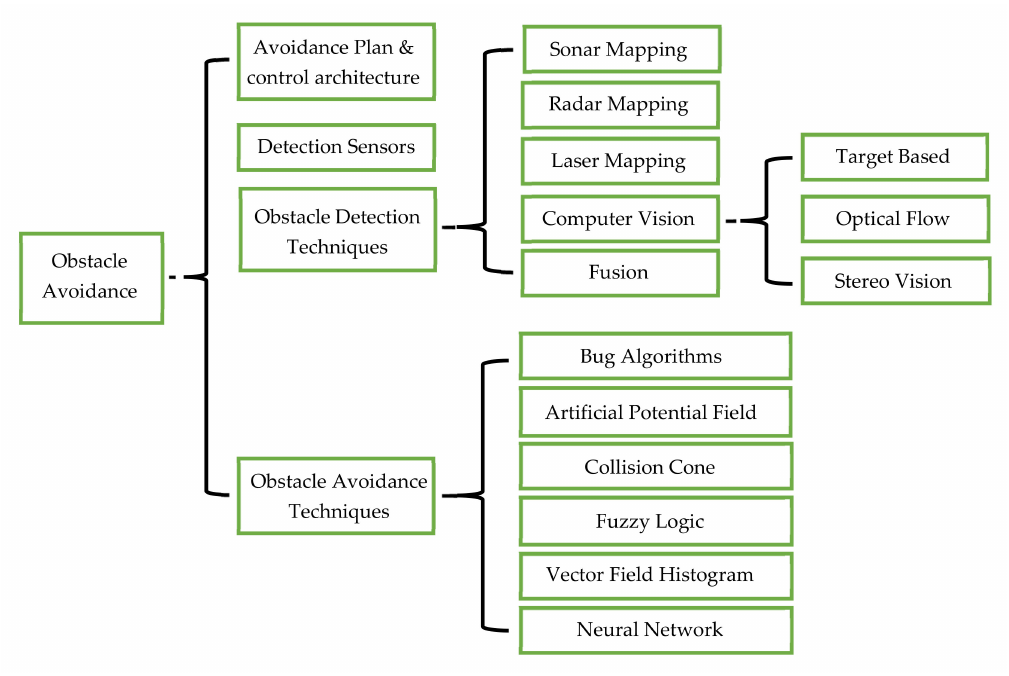
Figure 7. Obstacle avoidance scenario group.